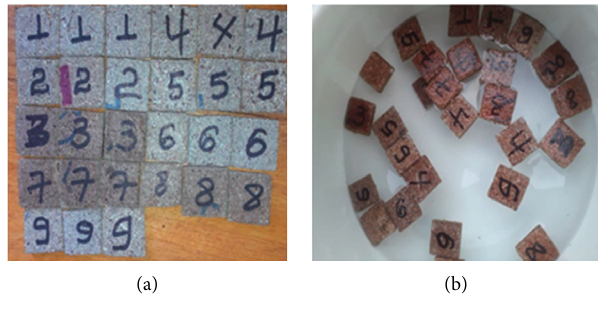
Figure 5: Water absorption testing.